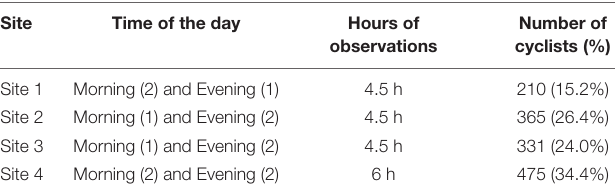
TABLE 1 | Observation